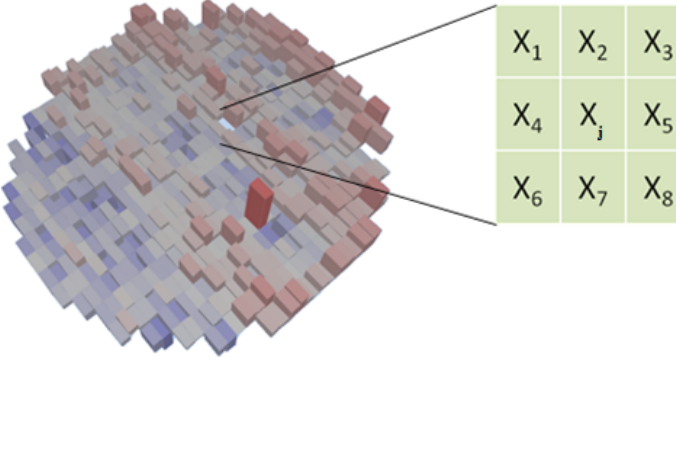
Figure 10. Nearest Neighbor